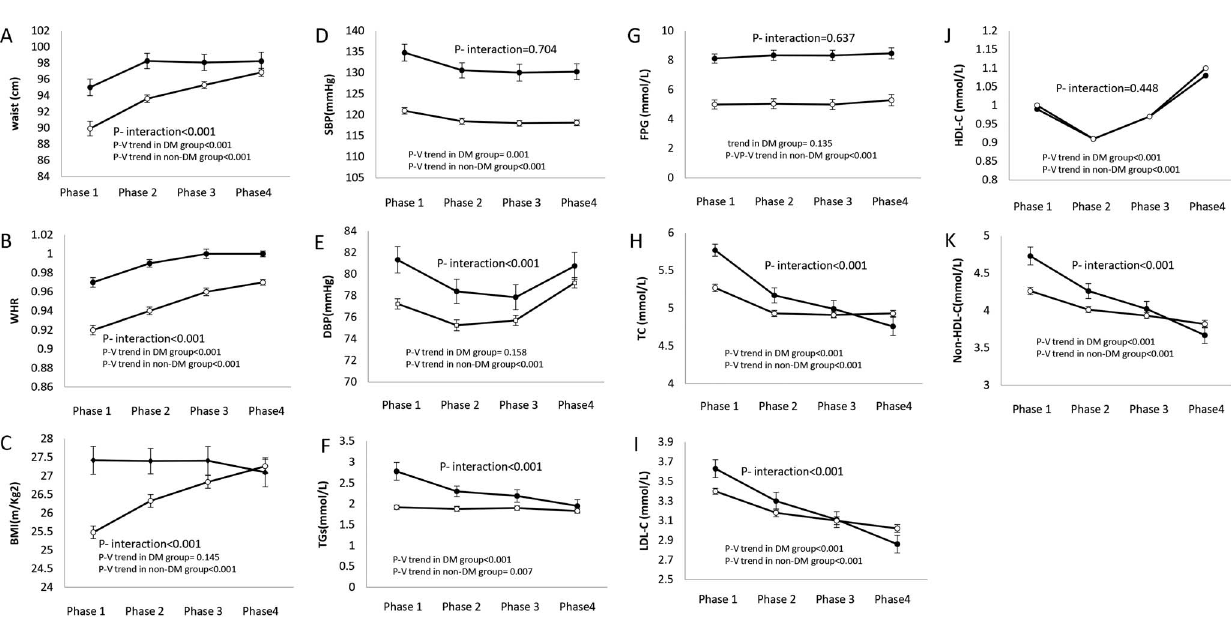
Figure 2. Age-adjusted mean levels of cardiovascular risk factors in each phase in male subjects. Mean levels of cardiovascular risk factors of diabetic and non-diabetic participants was calculated separately with adjustment of related participants’ age in each phase while the interaction of diabetes status was assessed in a pooled model consisting both diabetic and non- diabetic participants. Black circles 5 diabetic group; white circles 5 non diabetic group; DM, diabetes mellitus; WHR, waist to hip ratio; BMI, body mass index; SBP, systolic blood pressure; DBP, diastolic blood pressure; TGs, triglycerides; FPG, fasting plasma glucose; TC, total cholesterol; LDL, low-density lipoprotein cholesterol; HDL-C, high-density lipoprotein cholesterol; Non-HDL-C, non- high-density lipoprotein